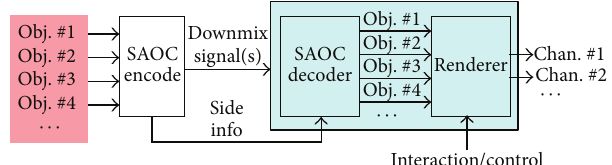
Figure 5: Basic structure of SAOC encoding and decoding. The encoder takes separated audio object signals as input; the decoder allows for interactive rendering of the loudspeaker signals.